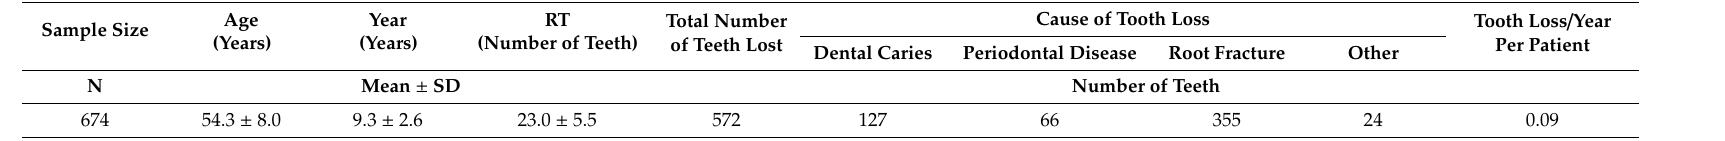
Table 1. Characteristics of patients in this study.